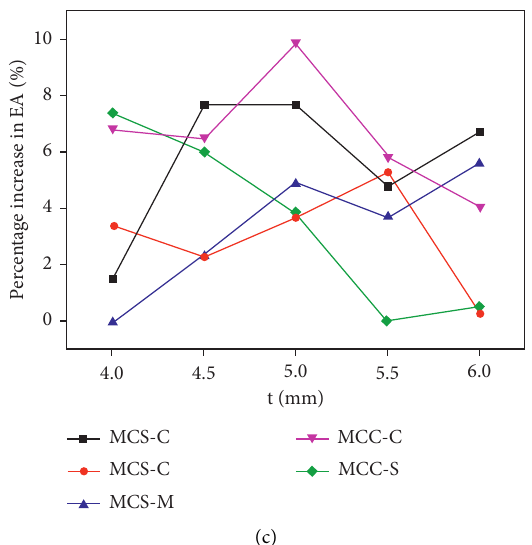
Figure 14: Improvement in the crashworthiness of different windowed structures under optimal SEA. (a) SEA. (b) PCF. (c) EA.